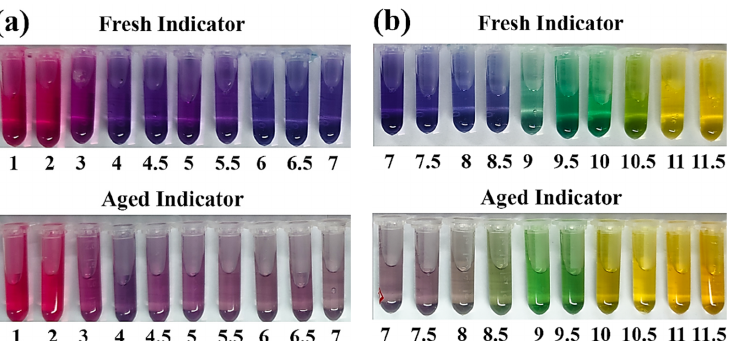
Figure 3. Discoloring behavior of fresh and aged F. orchid indicators exposed to pH ranges of ( a ) 1.0 to 7.0 and ( b ) 7.0 to 11.5.